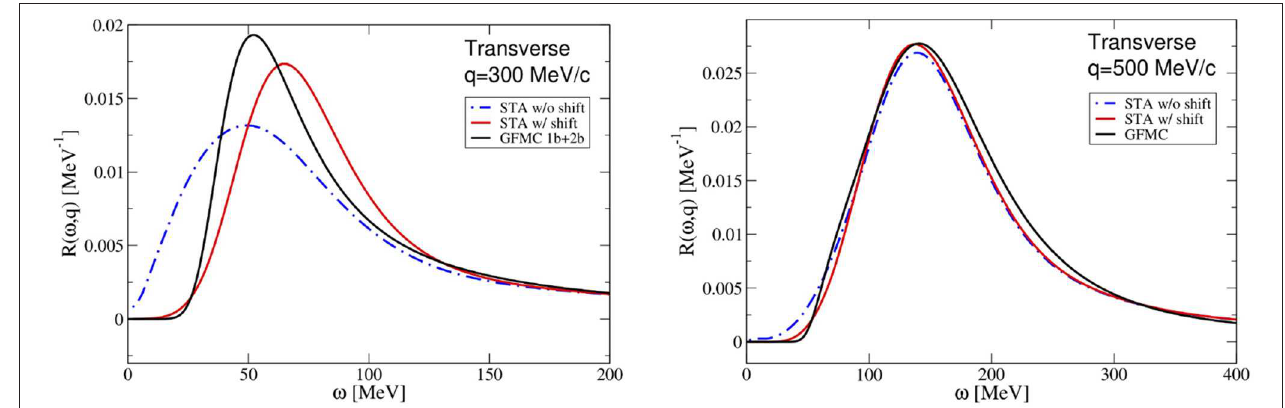
FIGURE 5 | Transverse electromagnetic response of 4 He obtained within the STA and GFMC approaches. The left and right panel corresponds to | q | = 300 and 500 MeV, respectively. The dashed (blue) and solid (red) lines are STA calculations prior and including the shift; the solid (black) line displays the GFMC results. Figure adapted from Pastore et al. [28].